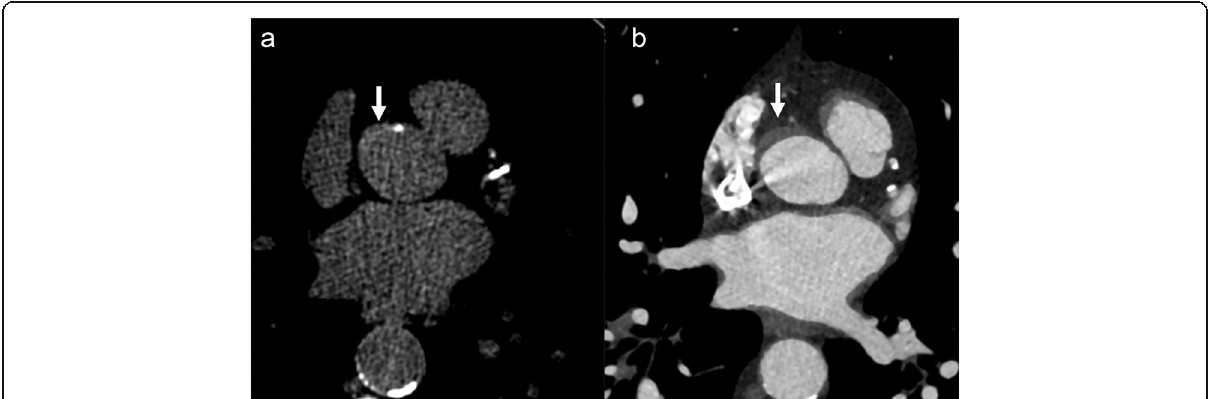
Fig. 9 A 72-year-old male with chest pain after conventional angiography done as a part of valve-in-valve surgical clearance. Non-contrast ( a ) and contrast-enhanced ( b ) CTA images showing hyperdense aortic wall thickening at the sinotubular suggesting focal intramural hematoma,